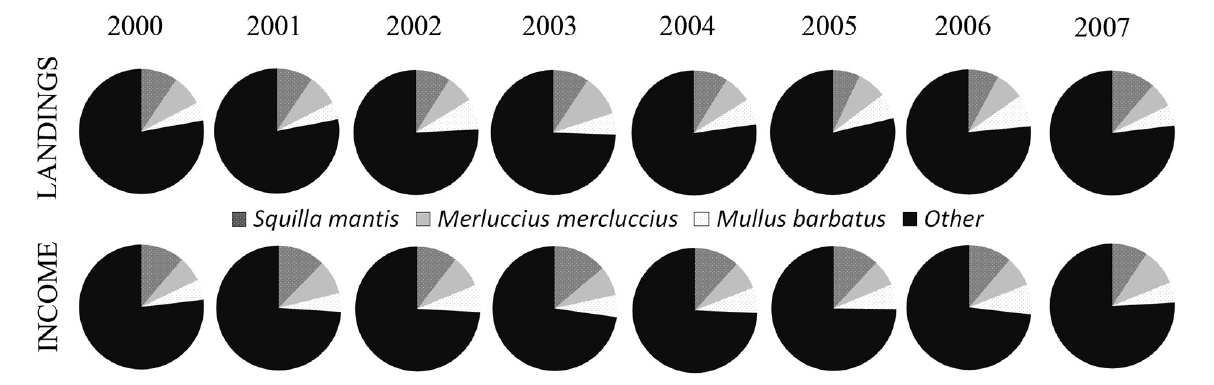
Fig. 3. – Percentage of landings and income for the main target species of the Sant Carles de la Ràpita trawling fleet.